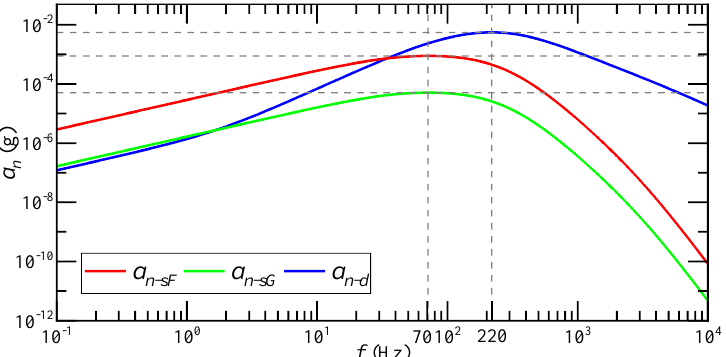
Figure 8. The relationship between the magnitude of a n and the frequency of a i under 1 g input acceleration.